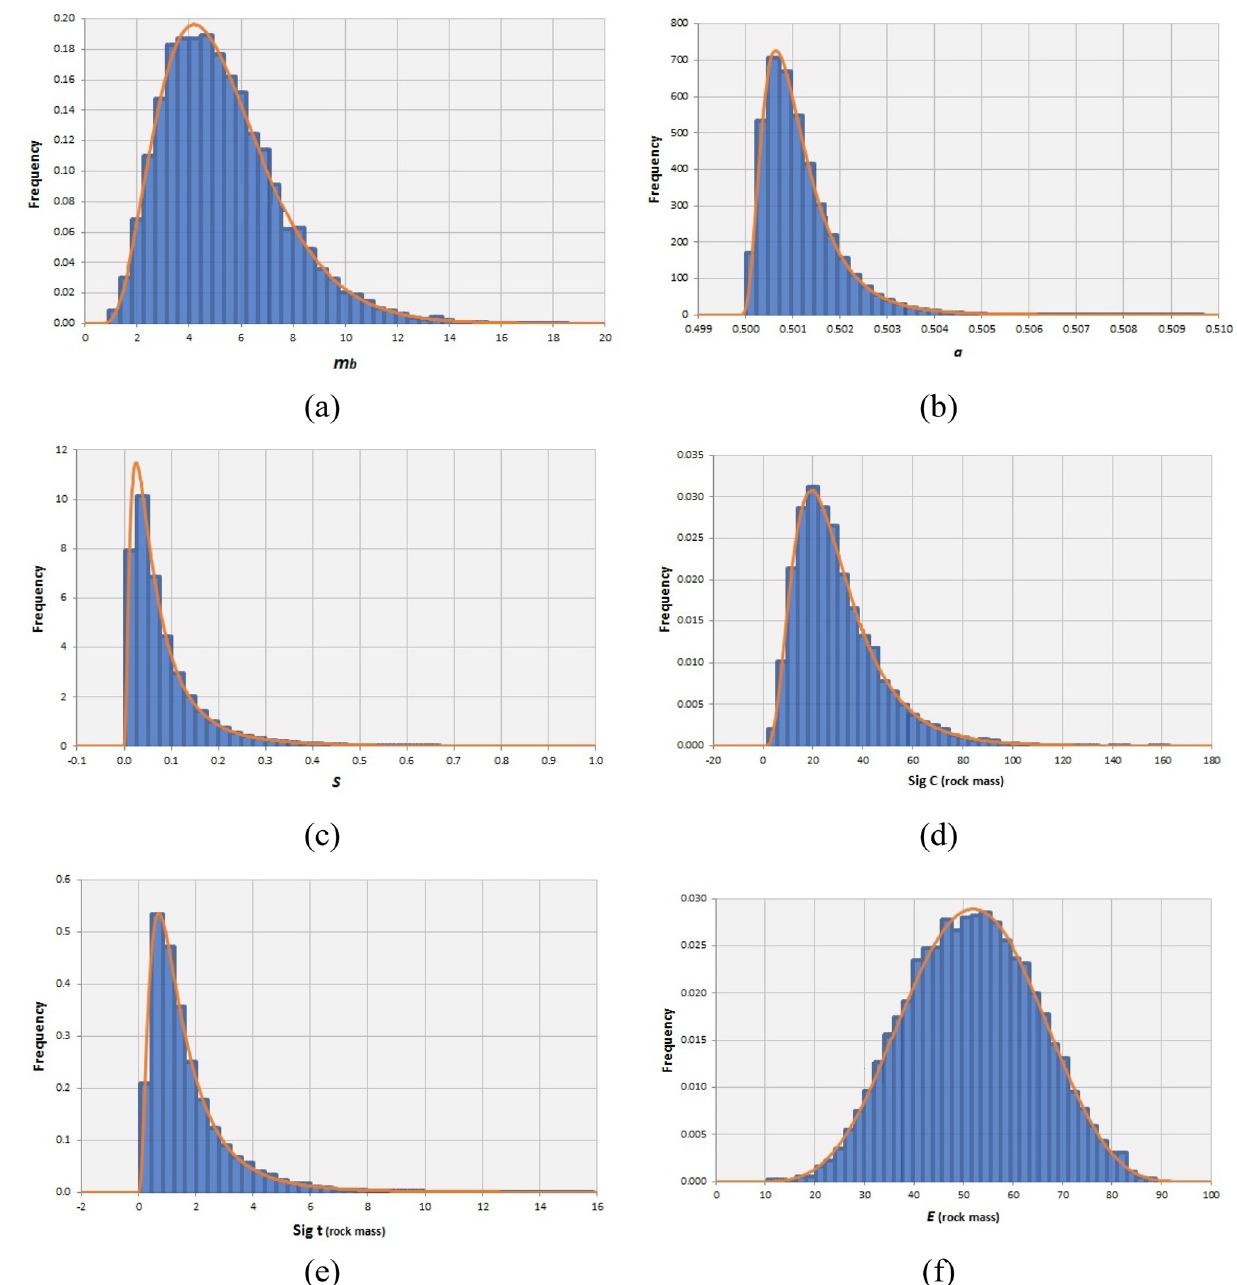
Fig. 10 Histograms and the best-fitted PDF of the geomechanical parameters of the carbonatite rock